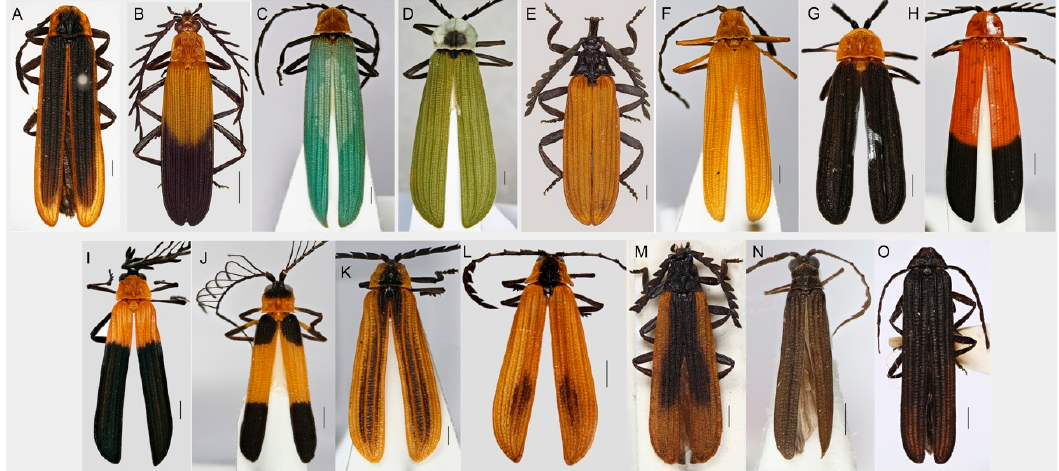
Figure 1. The representatives of the subtribe Metriorrhynchina, general appearance. ( A ) Metriorrhynchus eremita (Blackburn), Australia; ( B ) M. doleschali (Redtenbacher), Ceram; ( C ) Metriorrhynchus sp., New Guinea; ( D ) Porrostoma sp., New Guinea; ( E ) Porrostoma rhipidium (Macleay), Australia; ( F ) Eniclases sp., New Guinea; ( G ) Synchonnus testaceithorax Pic, New Guinea; ( H ) Ditua sp., New Guinea; ( I ) Flabellotrichalus sp. New Guinea; ( J ) Pseudodontocerus sp., New Guinea; ( K ) Trichalus sp., Australia; ( L ) Synchonnus crypticus Kusy et al., Australia; ( M ) Porrostoma sp., Australia; ( N ) Wakarumbia linearis Dvorak & Bocak, Sulawesi; ( O ) Sulabanus sp., Sulawesi. Scales 0.5 mm.